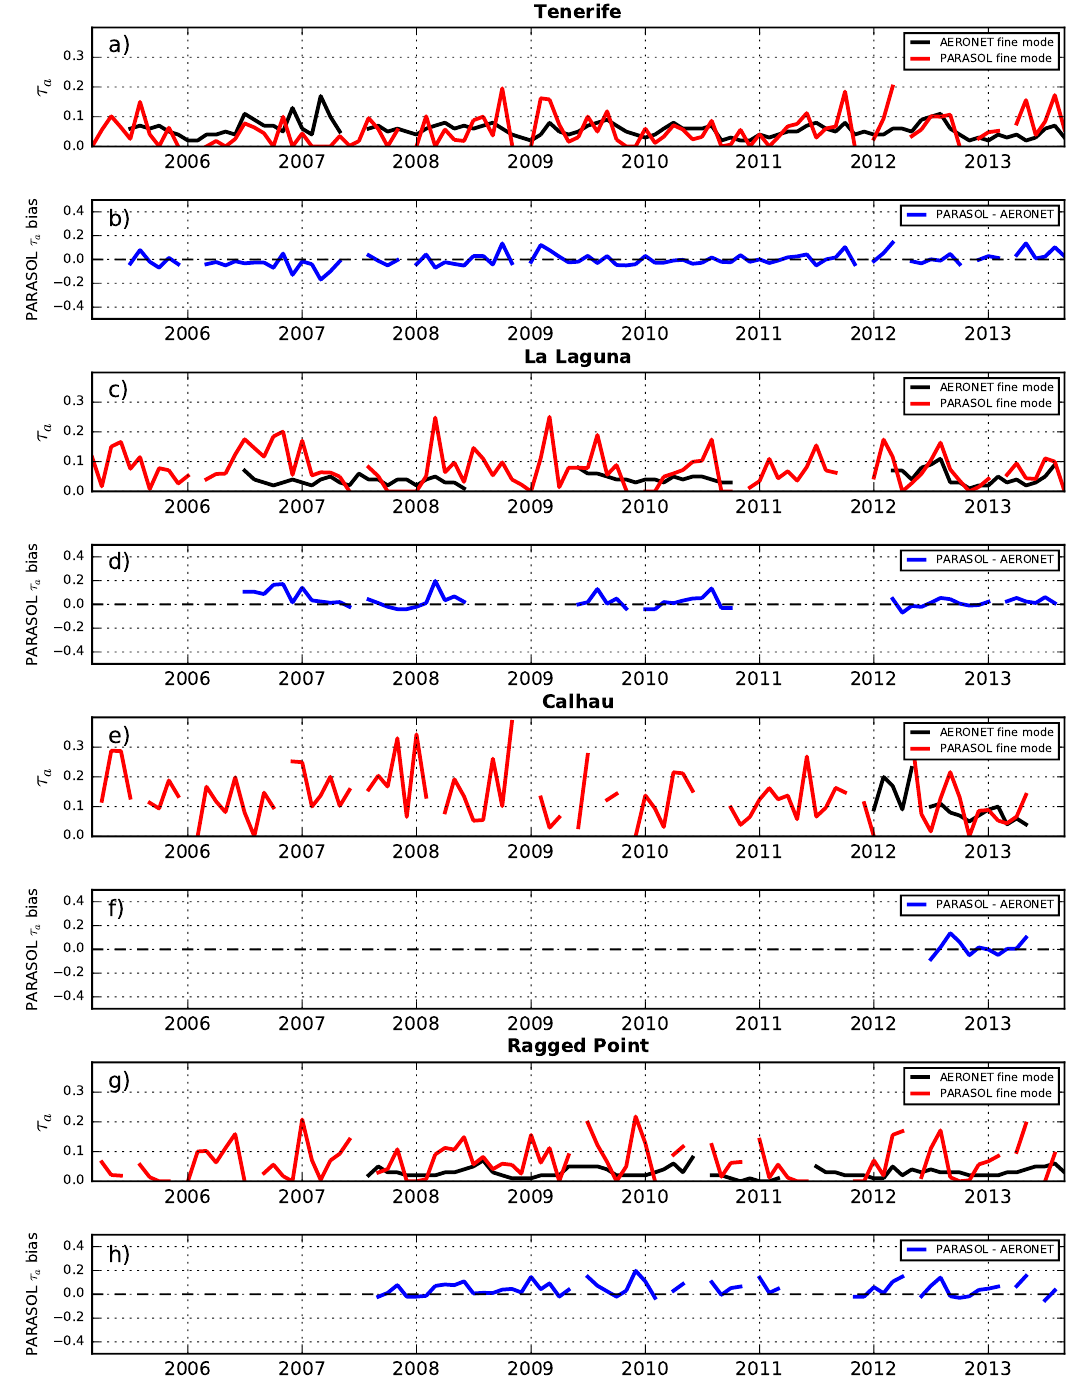
Figure 3. Similar as Figure 2 but for AOD f (fine mode of aerosols): ( a ) Tenerife, ( c ) La Laguna, ( e ) Calhau and ( g ) Ragged Point. Corresponding PARASOL AOD f bias with respect to AERONET: ( b ) Tenerife, ( d ) La Laguna, ( f ) Calhau and ( h ) Ragged